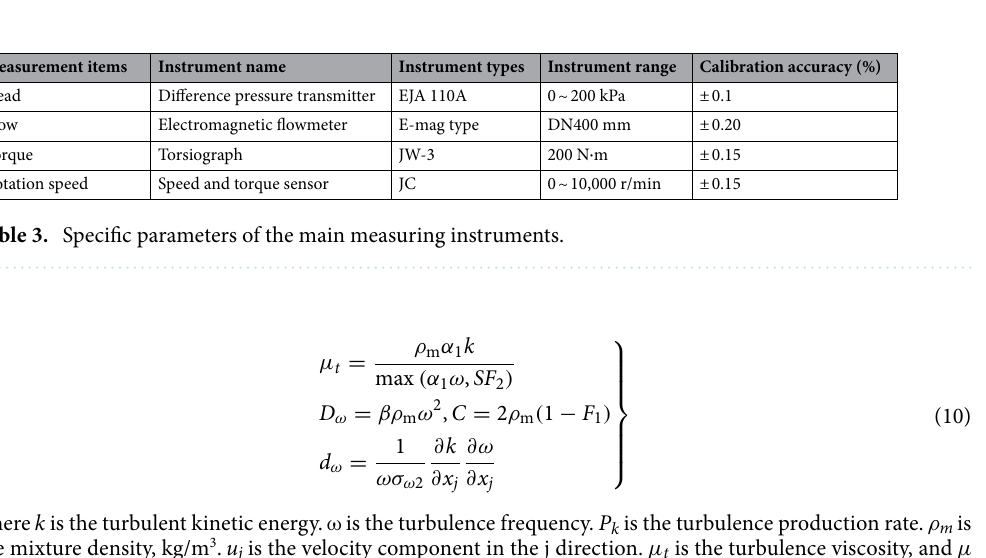
Figure 3. Physical schematics of the test bench. 1. Intake tank, 2. Tested pump unit and drive motor, 3. Pressure outlet tank, 4. Bifurcation tank, 5. Condition-regulating gate valve, 6. Voltage-regulating rectifier, 7. Electromagnetic flowmeter, 8. System forward and reverse operation control gate valve, 9. Auxiliary pump unit.